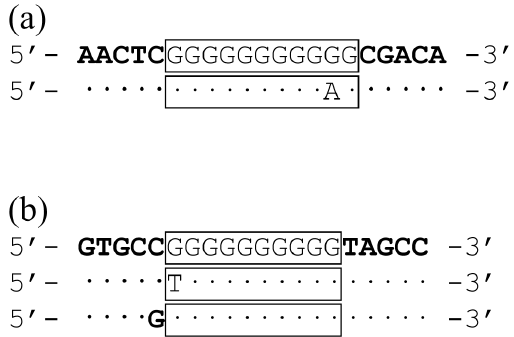
Figure 2. Sequence diversity in the homopolymeric tract regions of hmbR and hpuA . Due to polymorphisms in the homopolymeric tract and flanking regions, the phase variation expression status could not be reliably correlated with the absolute number of consecutive G repeats (absolute tract length), rather it corresponded with an ‘effective tract length’ between defined flanking regions. In the examples provided, tracts are illustrated as pairwise nucleotide alignments in which the defined flanking regions are highlighted using bold type whilst the effective tract length is denoted by a box. Pairwise nucleotide identities are denoted by dots. For hmbR (a) the defined flanking regions were AACTC and CGACA, respectively. In the upper example the effective and absolute tract lengths are the same (11 Gs vs 11 bases). The lower tract has a G to A substitution at the second to last G giving an absolute tract length of 9 Gs whilst the effective tract length remains 11 bases. For hpuA (b) the defined flanking regions were GTGC(C/G) and TAGCC, respectively. In the upper example the effective and absolute tract length are the same (10 Gs vs 10 bases). The middle example has a G to T substitution at the first G giving an absolute tract length of 9 Gs whilst the effective tract length remains 10 bases. The lower example has a C to G substitution immediately before the prototypical tract region giving an absolute tract length of 11 Gs whilst the effective tract length remains 10